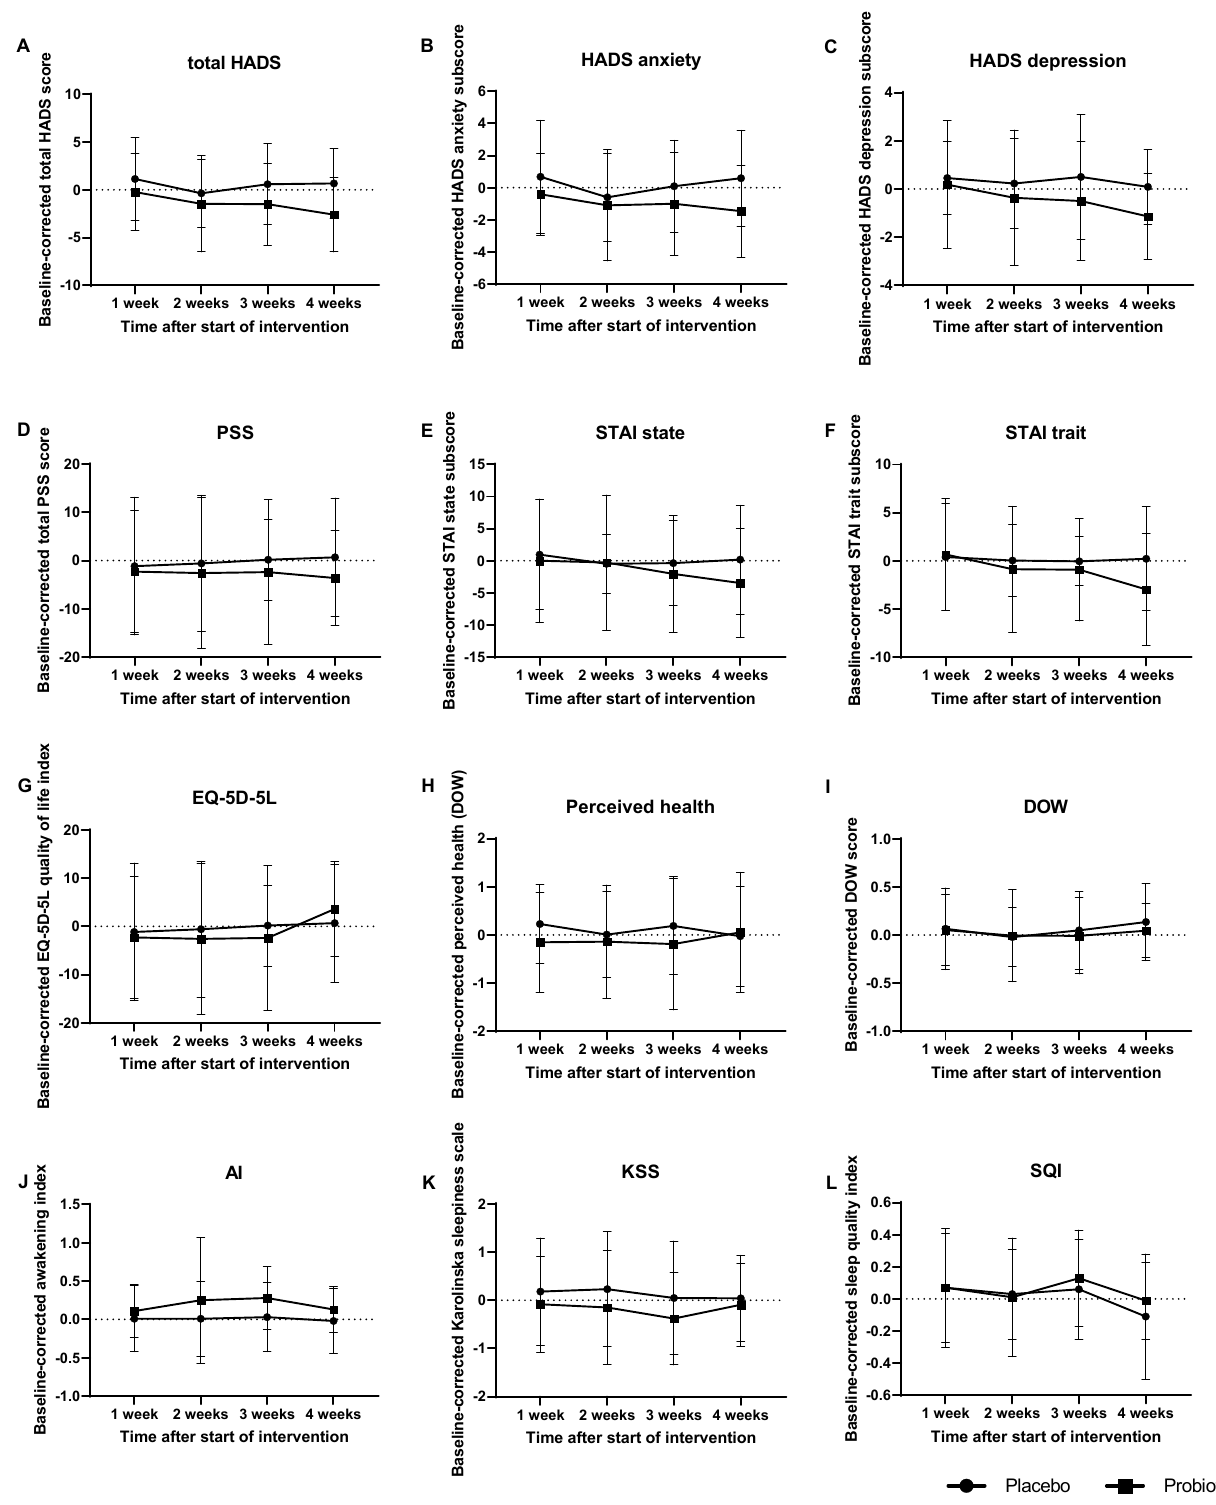
Figure 4. Effect of probiotic intervention on psychological symptoms, general health and sleep quality. ( A – C ) HADS—Hospital Anxiety and Depression Scale; ( D ) PSS—Perceived Stress Scale; ( E , F ) STAI—State and Trait Anxiety Inventory; ( G ) EQ-5D-5L—Euro Quality of Life version 5D-5L; ( H ) Perceived health (subscale of DOW); ( I ) DOW—Diary of Workload; ( J ) AI—Awakening Index; ( K ) KSS—Karolinska Sleepiness Scale; ( L ) SQI—Sleep Quality Index. Baseline-corrected; mean and standard deviation are presented.